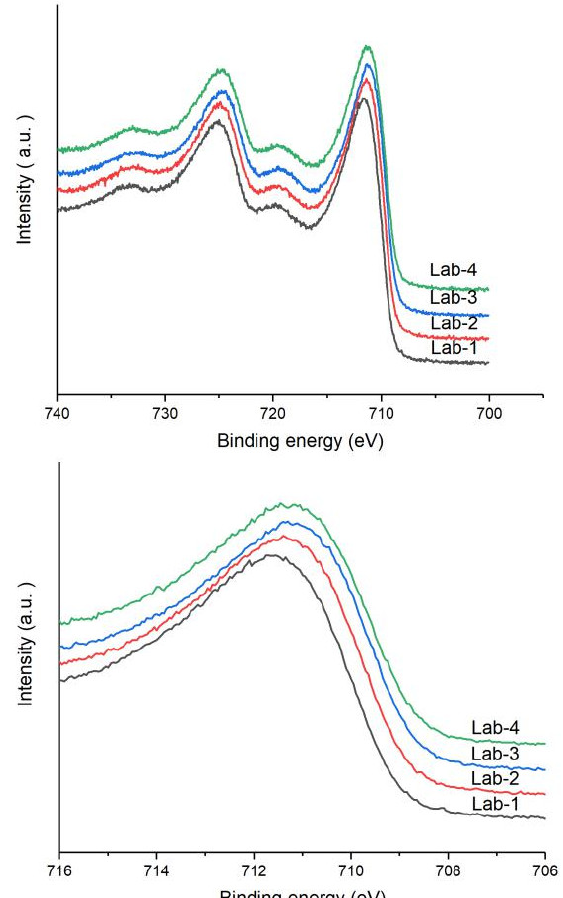
Figure 5. Fe2p spectra of as-prepared catalysts.